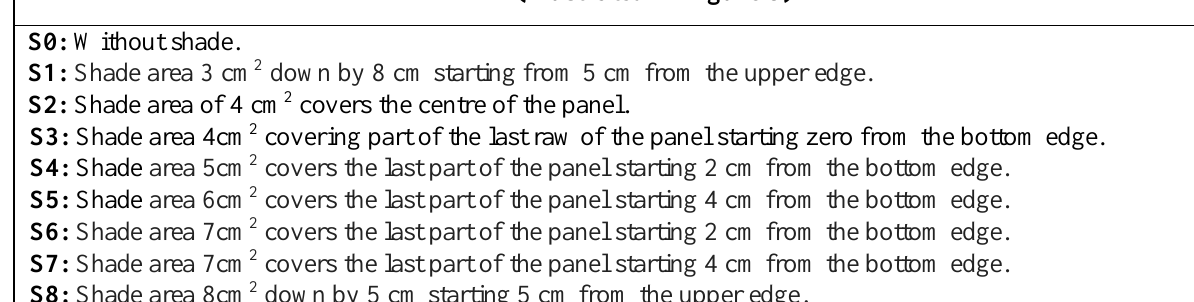
S8: Shade area 8cm 2 down by 5 cm starting 5 cm from the upper